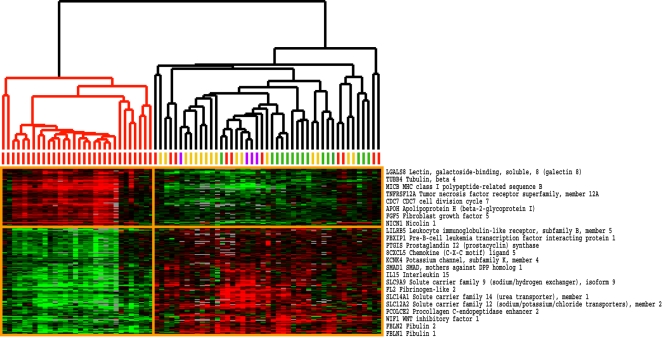
Genes correlated with MRSS.We selected the genes from the 995 intrinsic list that had a correlation greater than 0.5 or less than −0.5 to the MRSS. This list of 177 genes was then used to organize the skin biopsies. Forearm-back pairs from 14 patients with dSSc (mean MRSS of 26.34±9.42) clustered onto one branch of the dendrogram tree. The forearm-back pairs of 4 patients with dSSc (Mean MRSS 18.11±6.45) clustered onto a different branch of the dendrogram tree. The difference in skin score between these two groups is statistically significant (p<0.0197).